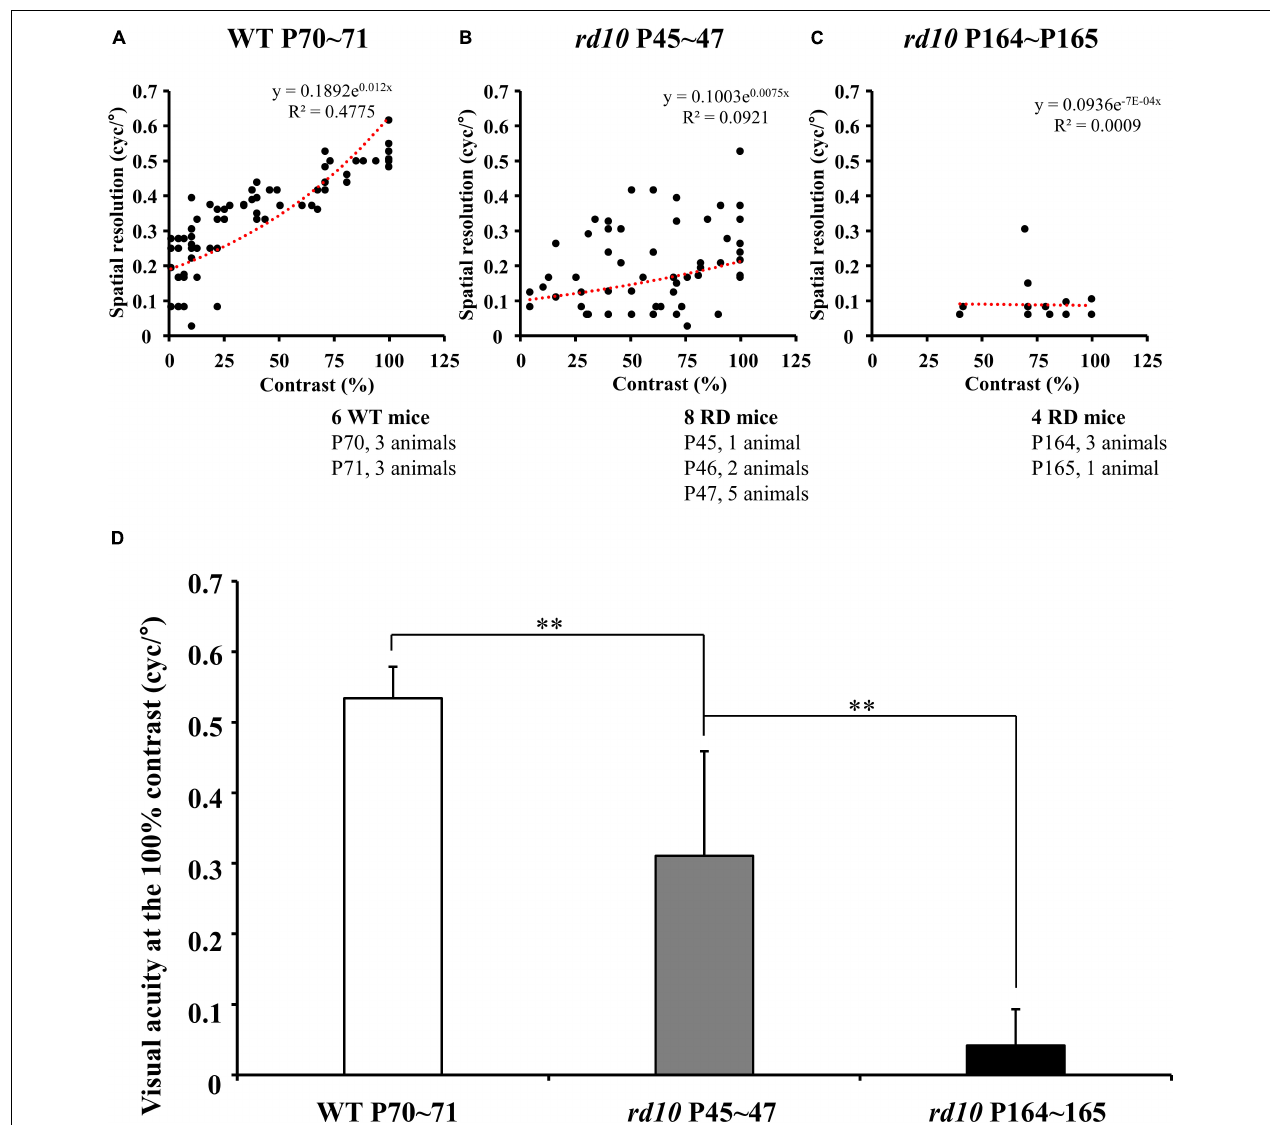
FIGURE 3 | The progressive decrease of visual acuity in rd10 mice. (A–C) The highest spatial resolution that induces the mouse’s optomotor response was measured under various contrast levels in wild-type (WT) (at P70–71) and rd10 mice (at P45–47 and P164–165). The highest spatial resolution measured from subjects within the same group was plotted on the graph without distinguishing the individuals. The linear regression line was fitted using an exponential function (red dashed line). Among old rd10 mice (P164–165), half animals did not show any optomotor response in this task. (D) The average visual acuity (mean ± SD) in a WT group and two rd10 groups were compared. The statistical analysis was performed with ANOVA, and post hoc analysis was performed with Tukey’s HSD and Duncan’s test (** p < 0.01).